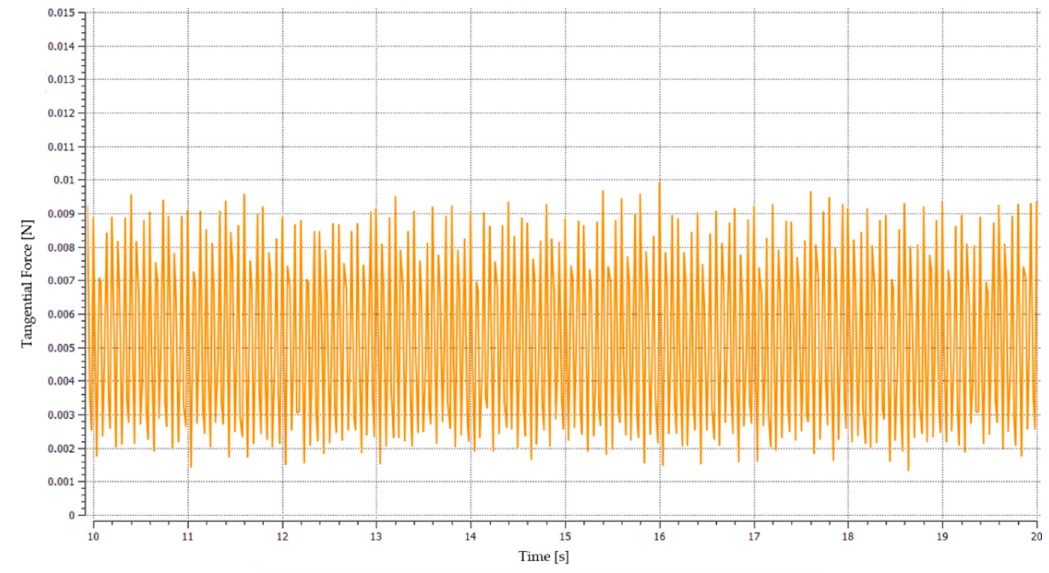
Figure 10. Standard deviation of the average force acting on the fruit in the tangential direction vibrating transport.